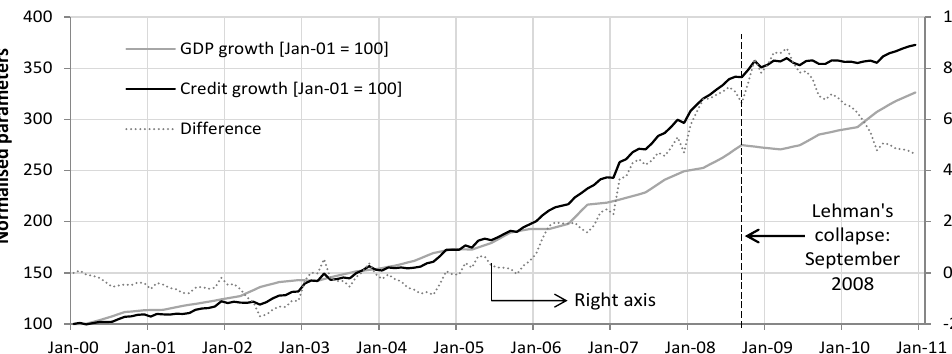
Application of the one- and two-sided HP filters to credit growth/GDP ratio for South African data commencing January 2000. Note the marked differences over the period preceding the credit crisis, i.e. January 2005 onwards